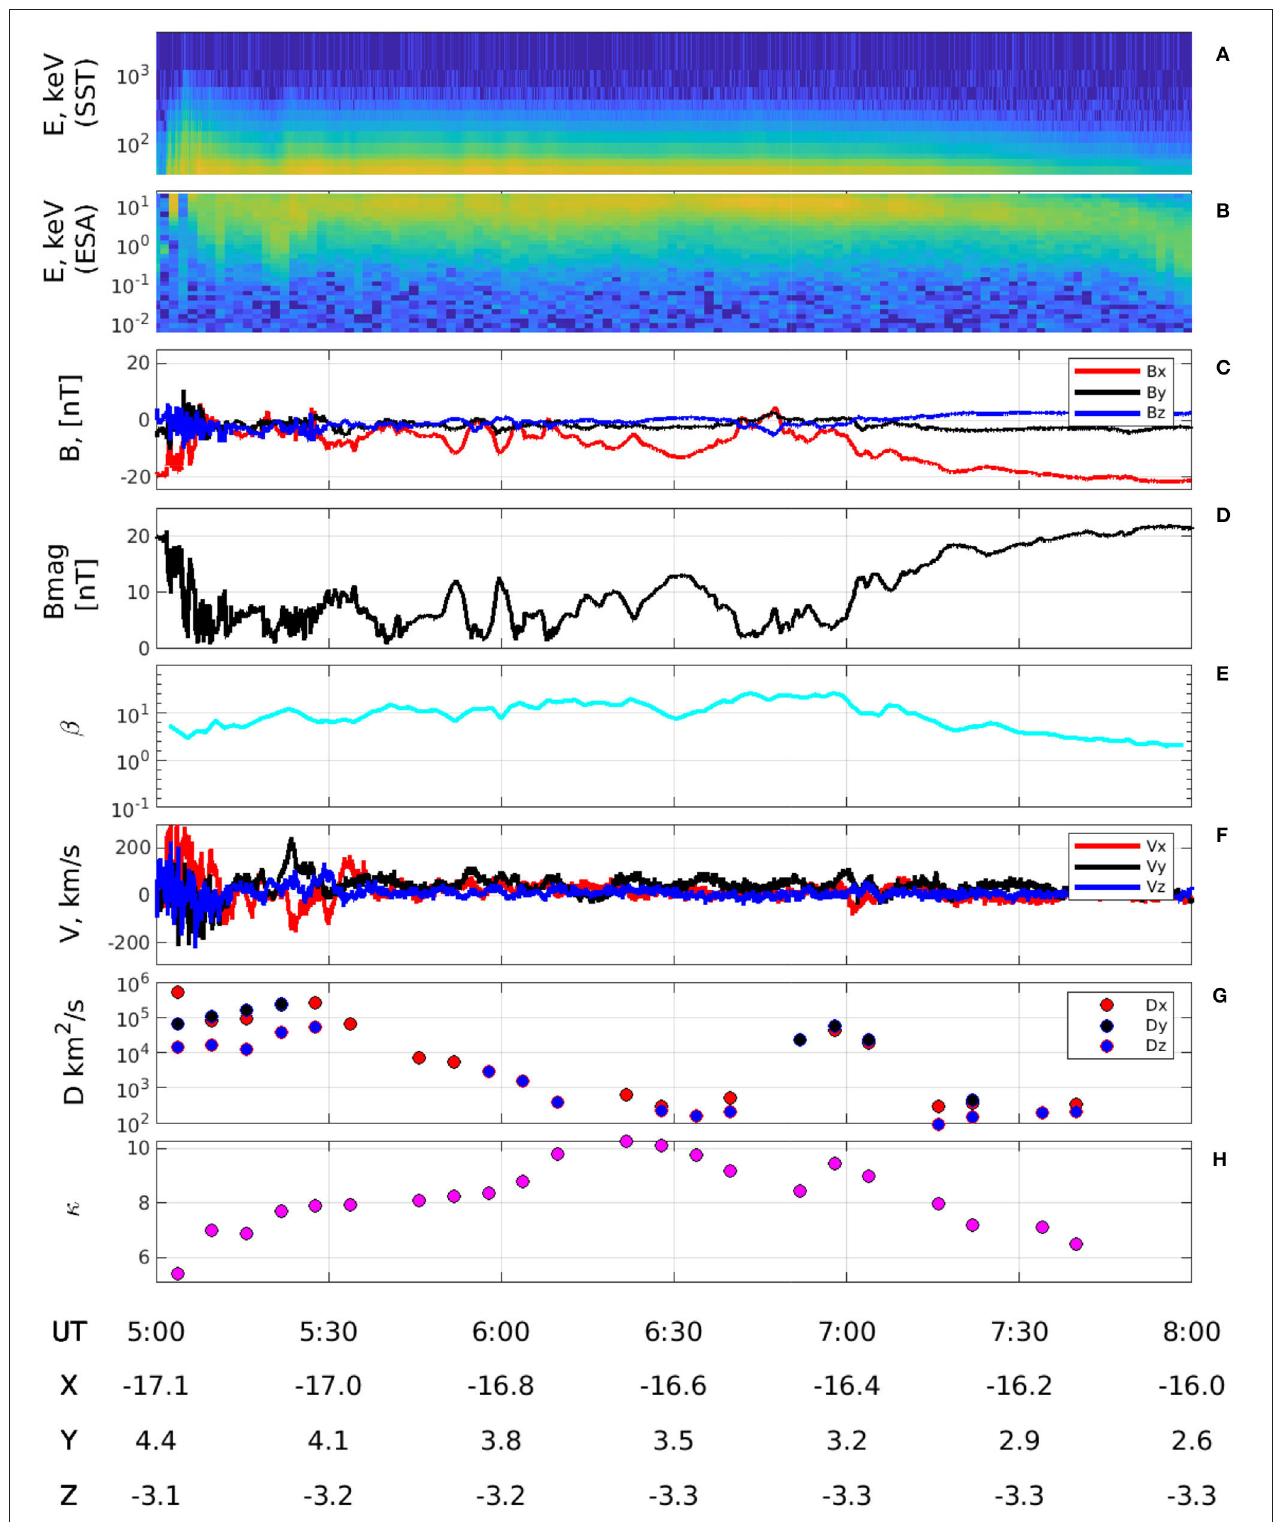
FIGURE 2 | Panels from top to bottom are the: (A) Ion spectrogram (SST), (B) Ion spectrogram (ESA), (C) Magnetic field components, (D) Magnetic field magnitude, (E) plasma β parameter, (F) Bulk velocity components, (G) Eddy diffusion coefficient, and (H) ion kappa-index obtained from the on-board moments of ion distribution function measured between 5 and 8 UT by THEMIS-C (THC) on 26 February